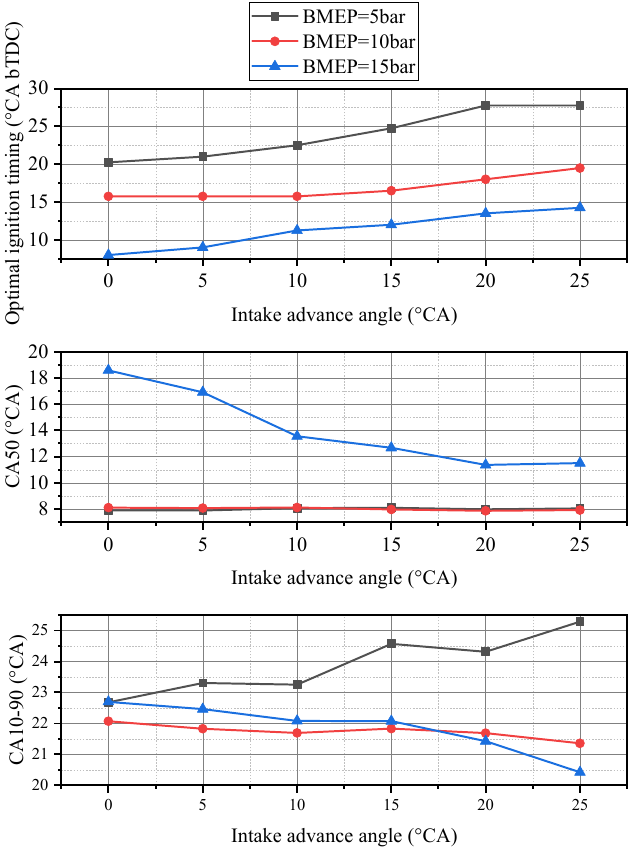
Figure 8. Optimal ignition timing, CA50, and CA10-90 versus intake advance angle under baseline EVC.